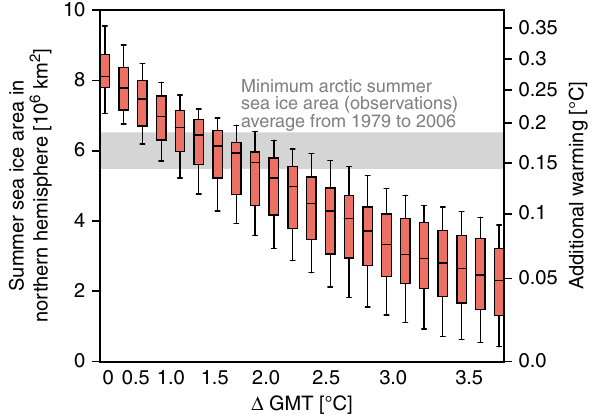
Fig. 4 Additional warming due to meltdown of Arctic summer sea ice. Box whiskers plot of global mean temperature ( Δ GMT) versus Arctic summer sea ice area with error boxes (error bars) representing the interquartile range (full spread) of the ensemble at the according GMT over the CLIMBER-2 ensemble runs. The additional warming when the Arctic summer sea ice disappears is represented by a second y-axis computed via a least-square fi t from the corresponding summer sea ice area. The relationship between summer sea ice area and additional warming is slightly nonlinear. This means that a doubling of the ice area does not quite translate into a doubling of the additional warming. The x-axis shows Δ GMT above pre-industrial computed via a GMT-CO 2 concentration least- square fi t. The shaded area shows the mean Arctic sea ice area as observed by NERSC (Nansen Environmental & Remote Sensing Center) from 1979 to 2006, where the uncertainty indicates one standard deviation: 6.0 ± 0.5 × 10 6 km 2